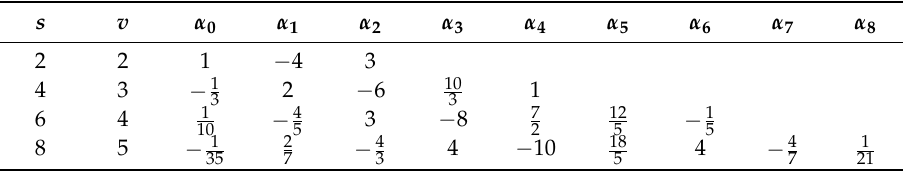
Table 1. The coefficients of generalized backward difference formulae (GBDF) using uniform grids (for even s ).